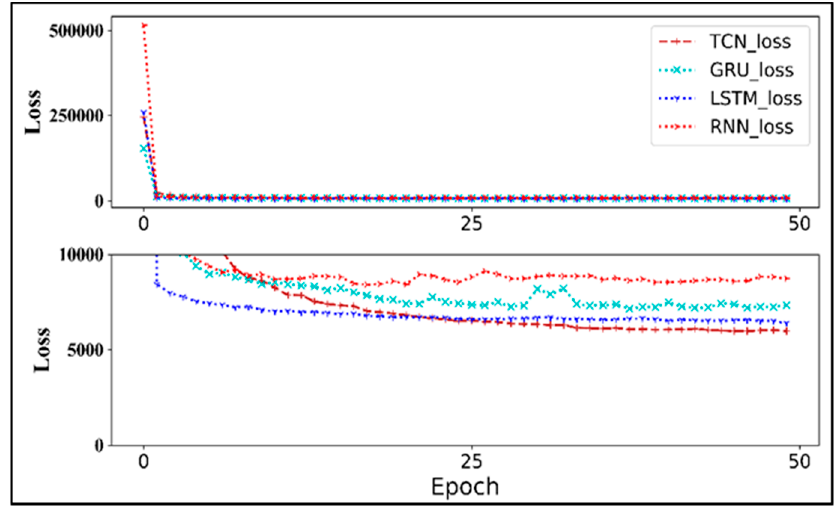
Figure 15. Convergence error of the cost function.